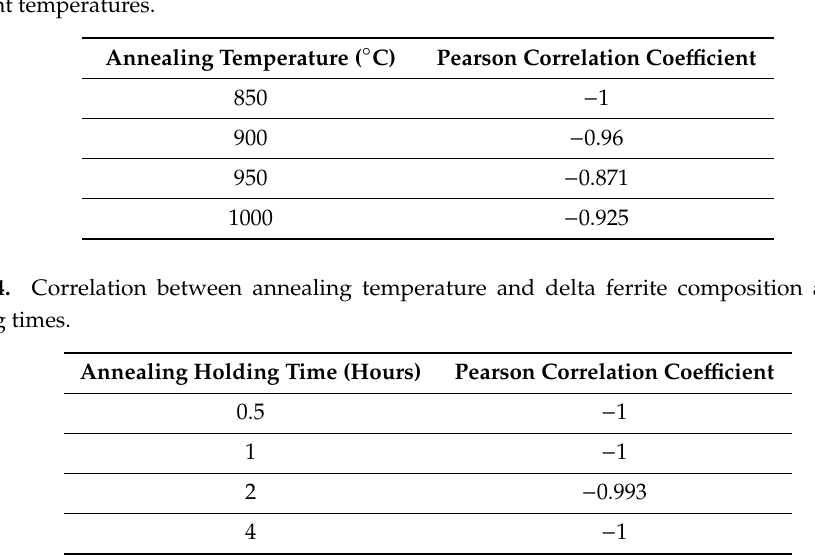
Table 3. Correlation between annealing holding time and delta ferrite composition at di ff erent temperatures.